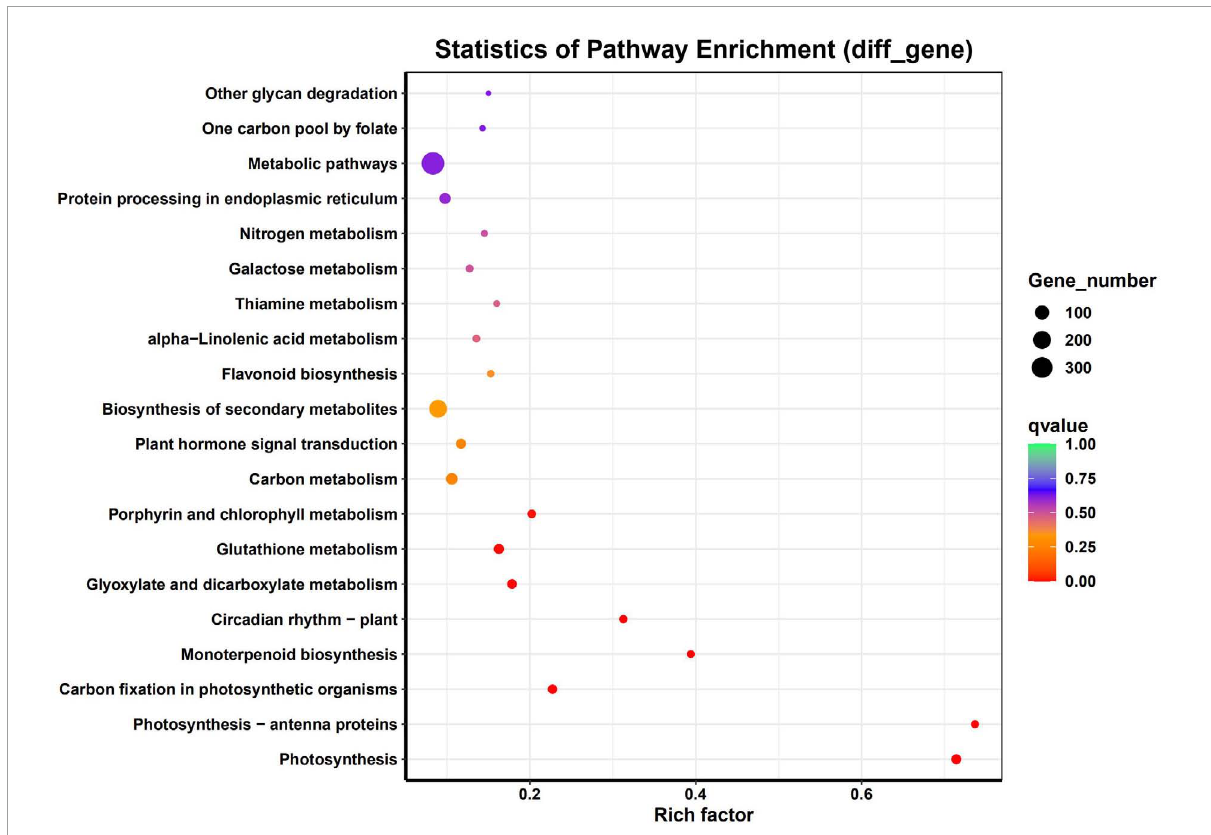
FIGURE4 Pathway analysis for significant DEGs. Graphical representation of numbers of DEGs enriched in common KEGG